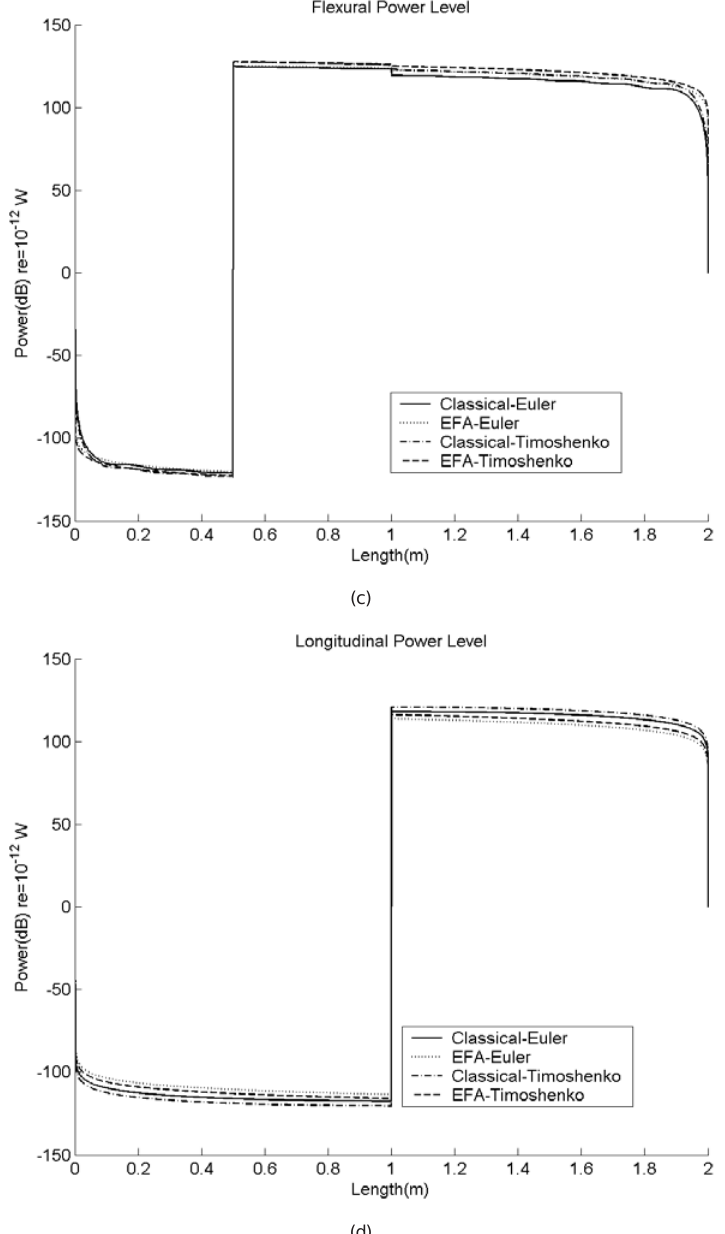
Fig. 11, contibued. The comparison of the time- and locally space-averaged energy and power levels of two Timoshenko beam with two Euler-Bernoulli beam structures coupled with θ = 45 ◦ when f = 1 kHz, η = 0 . 01 . The reference energy density is 1 × 10 − 12 J / m and the reference power is 1 × 10 − 12 W; (a) Flexural energy, (b) Longitudinal energy, (c) Flexural power, (d) Longitudinal power.